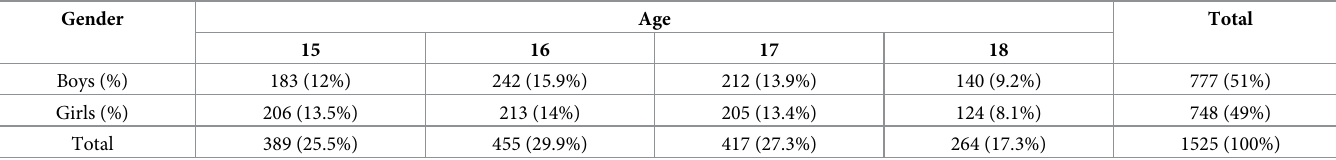
Table 1. Sample distribution by gender and